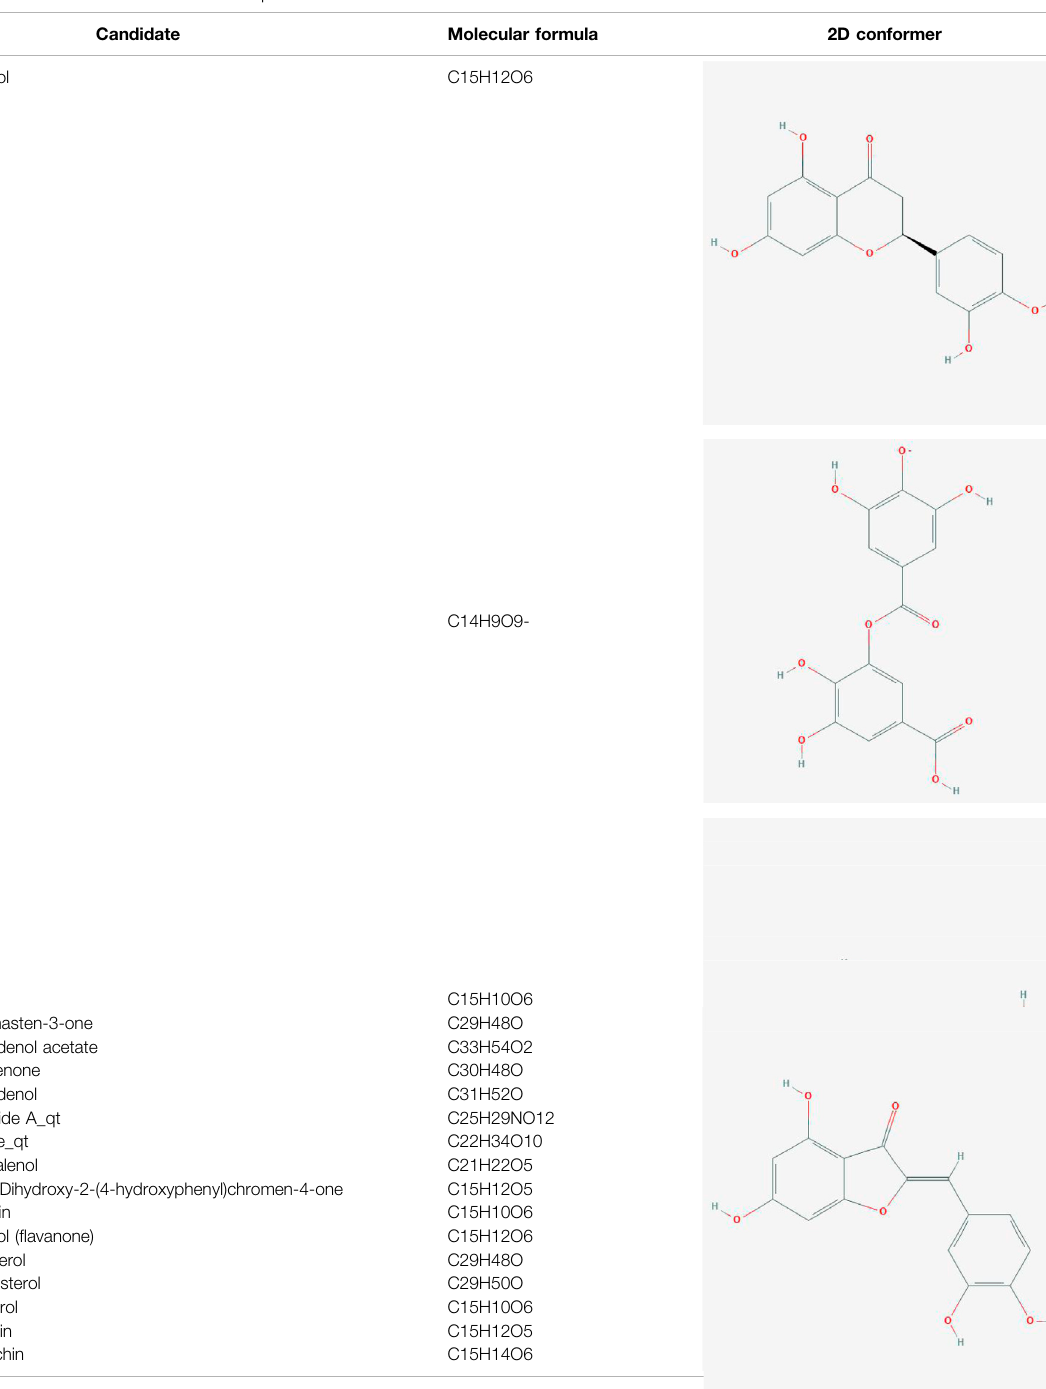
TABLE 4 | The network of TFDR consisted of 18 candidate